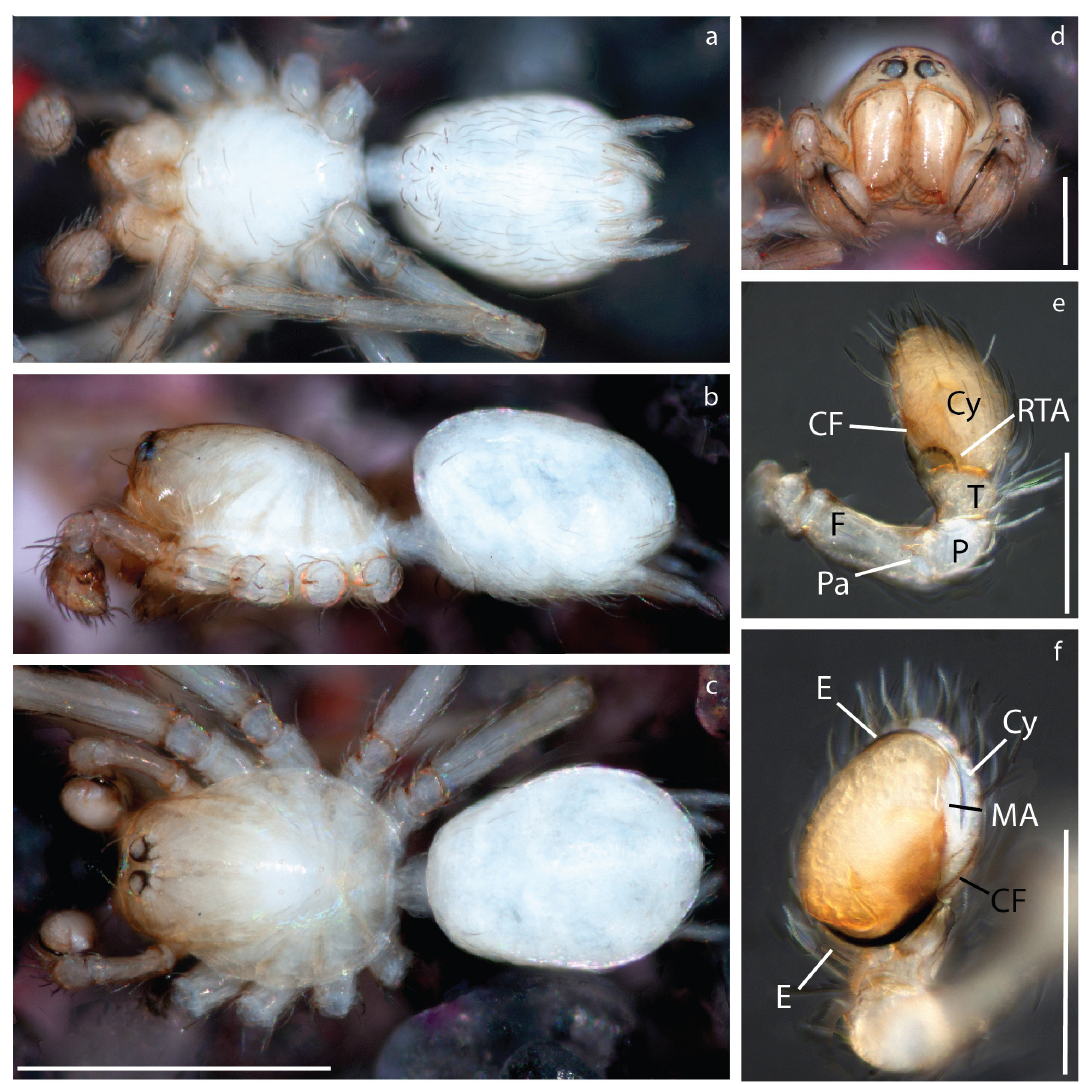
Fig. 2. Hexamatia seekhaow gen. et sp. nov., holotype, ♂ (RMNH.ARA.18411). a–c . Habitus. a . Ventral view. b . Lateral view. c . Dorsal view. d . Prosoma, anterior view. e–f . Palp. e . Retrolateral view. f . Ventral view. Scale bars: a–c = 0. 5 mm; d–f = 0.15